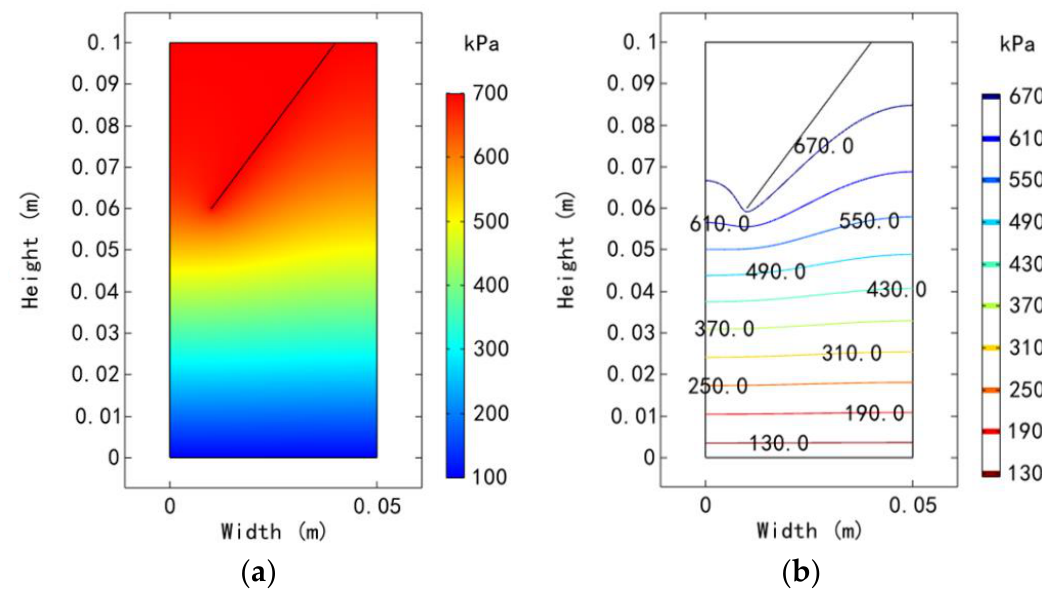
Figure 13. Distribution of gas pressure in the upper fracture model. ( a ) Gas pressure nephogram; ( b ) gas pressure isoline.